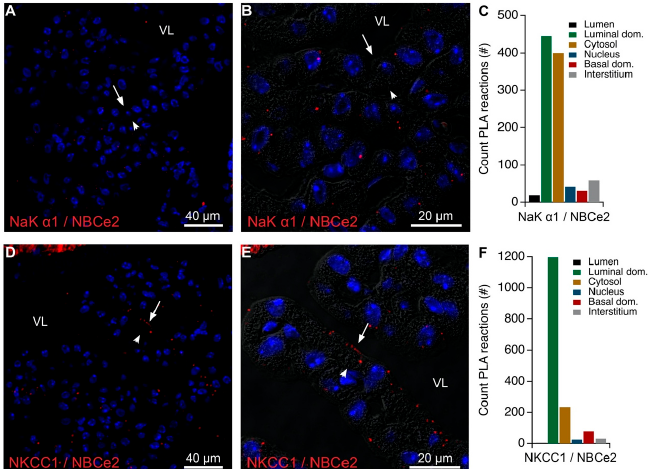
Figure 8. Colocalization of Na,K-ATPase α 1 or NKCC1 with NBCe2 by PLA. ( A ) Representative immunofluorescence image of PLA products (red) using anti-Na,K-ATPase α 1 (NaK α 1) and anti-NBCe2 antibodies and cell nucleus counter- stain (blue) at low magnification. ( B ) Higher magnification micrograph of the same structure overlaid on the correspond- ing DIC image. ( C ) Bar graph representing the count of PLA reactions in the indicated image areas. ( D ) Representative immunofluorescence image of PLA products (red) using anti-NKCC1 and anti-NBCe2 antibodies and cell nucleus coun- terstain (blue) at low magnification. ( E ) Higher magnification micrograph of the same structure overlaid on the corre- sponding DIC image. ( F ) Bar graph representing the count of PLA reactions in the indicated image areas. Arrows indicate luminal surfaces, while arrowheads mark basolateral surfaces. VL denotes the fourth ventricle lumen.